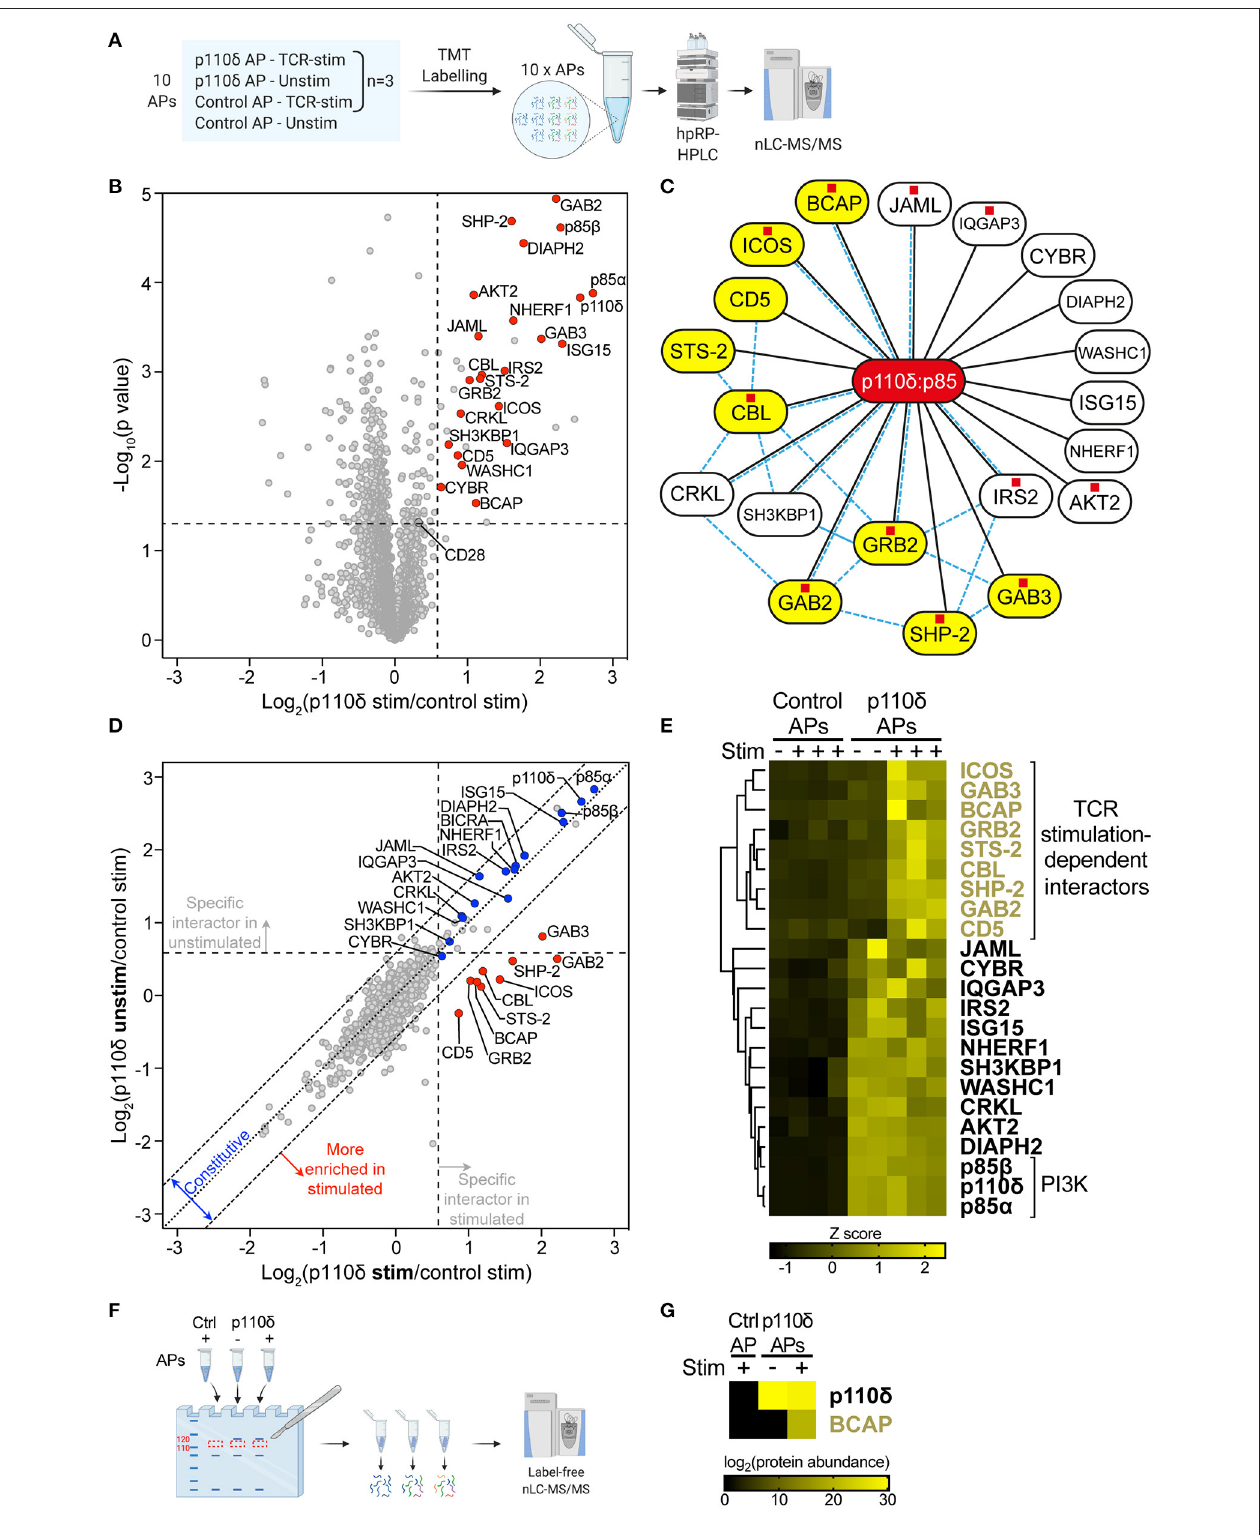
FIGURE 2 | The p110 δ interactome in CD4 + T cell blasts. (A) Schematic of samples analysed by quantitative MS. p110 δ and control APs were produced from unstimulated and TCR-stimulated CD4 + T cell blasts in three independent biological-repeat experiments (detailed in Supplementary Figures 3A,B ). Peptides